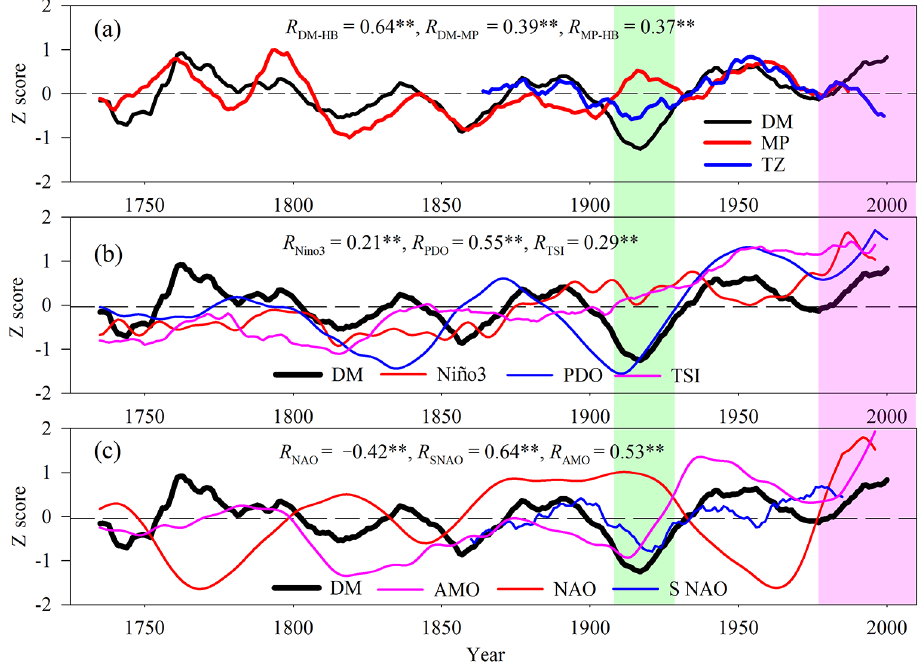
Figure 8. Comparisons of the drought reconstruction and other large-scale climate oscillations. (a) The dry–wet changes in the Daxing’an Mountains (DM, the average of our reconstruction and the precipitation reconstruction of the A’li River), the Mongolian Plateau (MP, the streamflow reconstruction of the Selenga River) as well as their transition zones (TZ, the SPEI reconstruction of the Hulun Buir steppe); (b) the drought reconstruction in the Daxing’an Mountains (DM), the Pacific Decadal Oscillation (PDO) and the Niño3 index reconstruction from Mann et al. (2009) (Niño3) as well as the total solar irradiance (TSI) reconstruction from IPCC AR5; (c) the drought reconstruction in the Daxing’an Mountains (DM), the Atlantic Multidecadal Oscillation (AMO) reconstruction from Mann et al. (2009), the multi-decadal winter North Atlantic Oscillation (NAO) reconstruction by Trouet et al. (2009) and the summer NAO based on the 20C reanalysis sea-level pressure reconstruction (SNAO). All above series were standardized using Z scores and then smoothed with a 21-year moving average to highlight low-frequency drought signals. Significant correlation coefficients ( ∗∗ p < 0 . 01) are listed in the